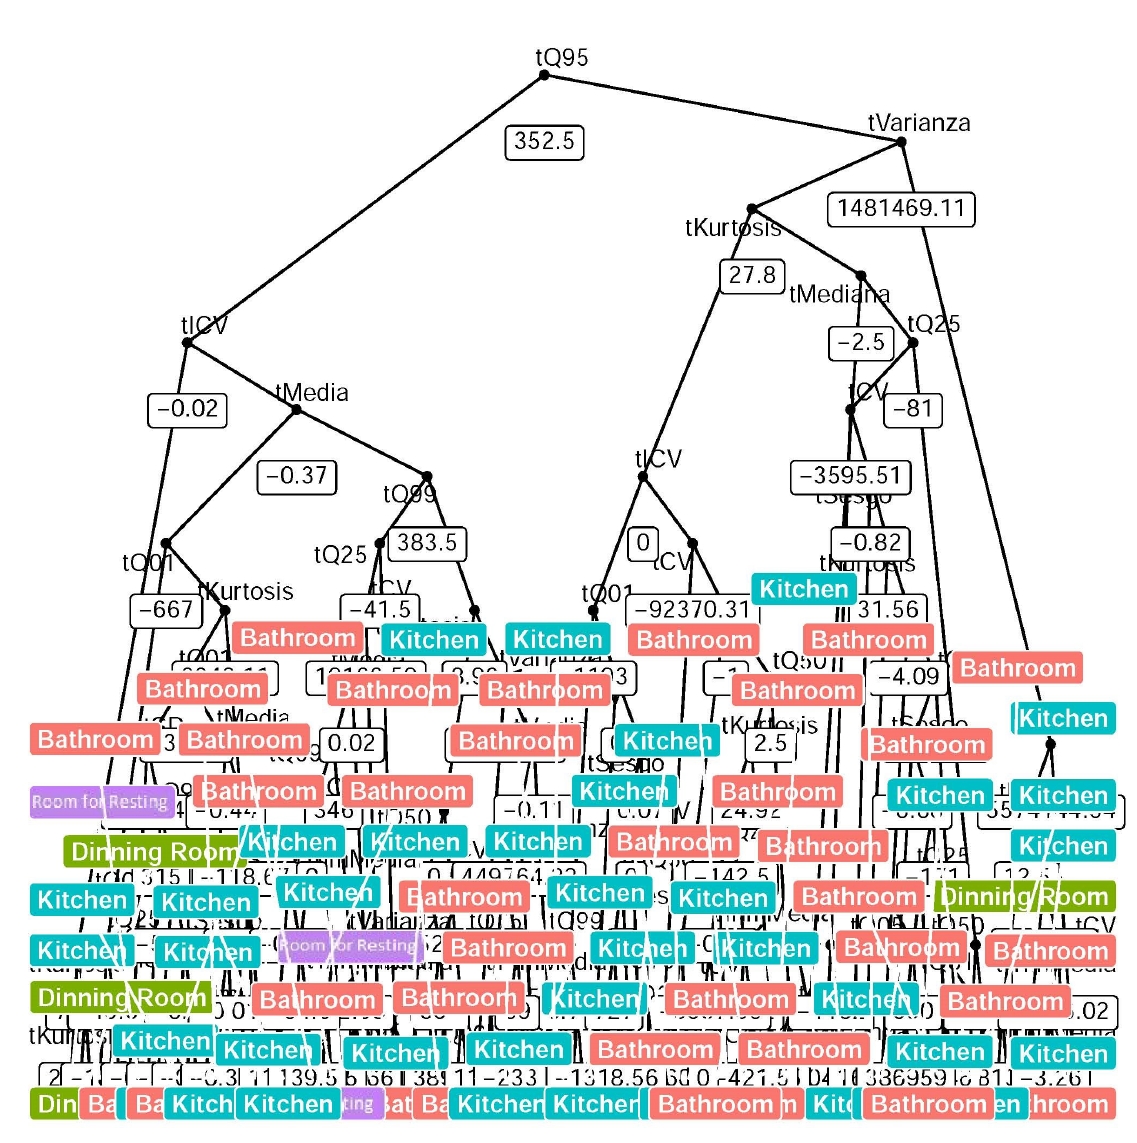
Figure 3. Minimal error tree from random forest 500 trees; all features are